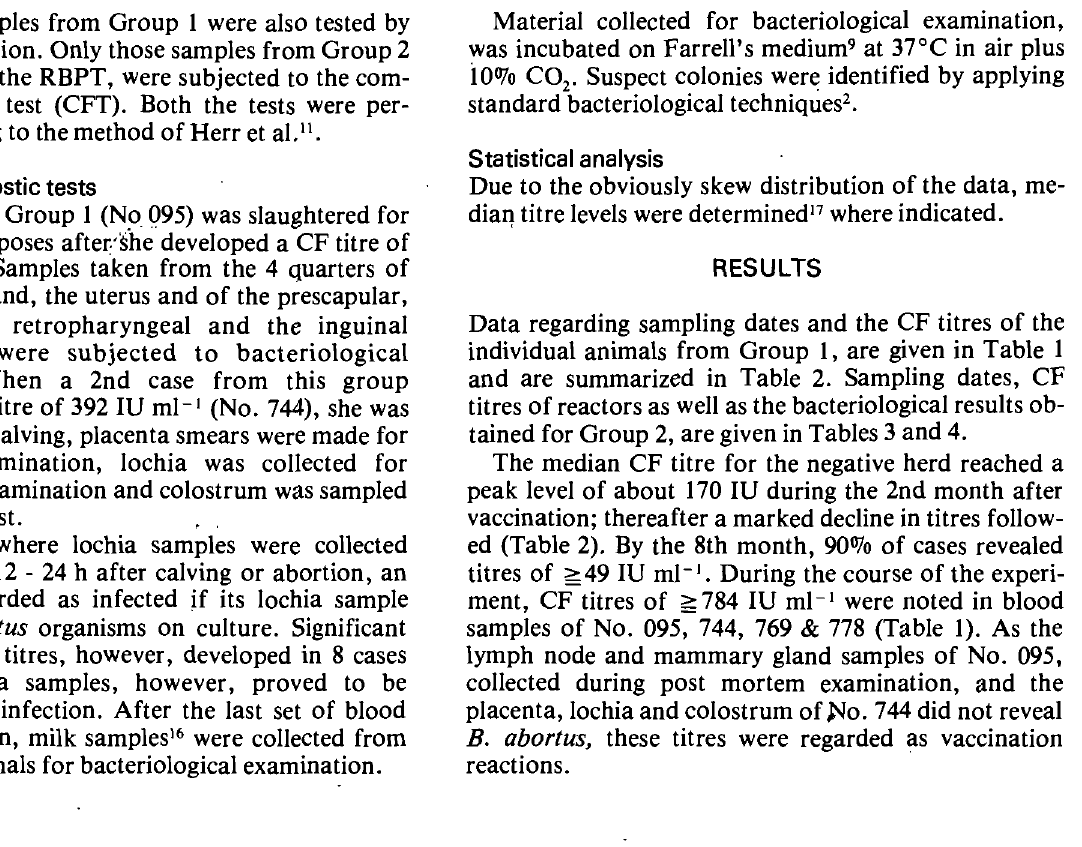
Table 1: Complement fixation tit res (lU me-I) for the individual animals from th~ known negative herd on different sampling dates. (Reduced dose Brucella abortus strain 19 vaccine injected on 11.04.1985). Cow CF titre on Day Cow CF titre on Day No.